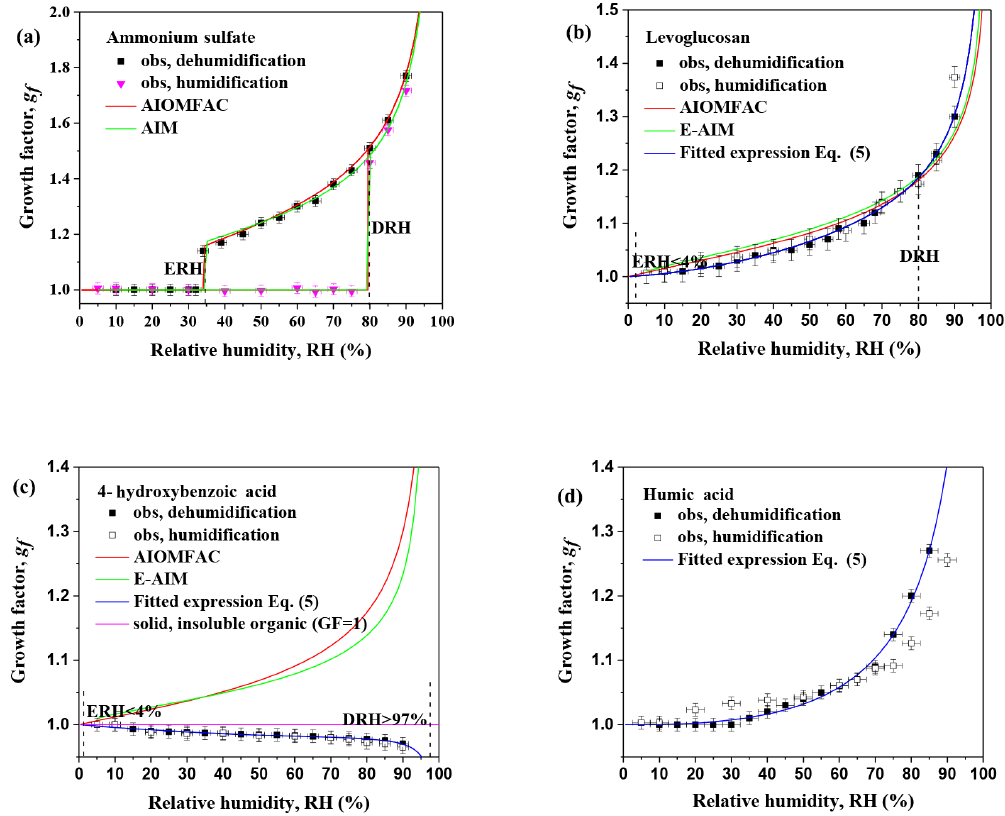
Figure 2. Hygroscopic growth, deliquescence, and efflorescence of aerosol particles. Hygroscopic growth factors of (a) ammonium sulfate (AS), (b) levoglucosan, (c) 4-hydroxybenzoic acid, and (d) humic acid aerosol particles with a dry diameter of 100nm (open, black square). In this study, the green curves show E-AIM predictions, the red curves the AIOMFAC predictions, and the blue lines the fitted expression (Eq.